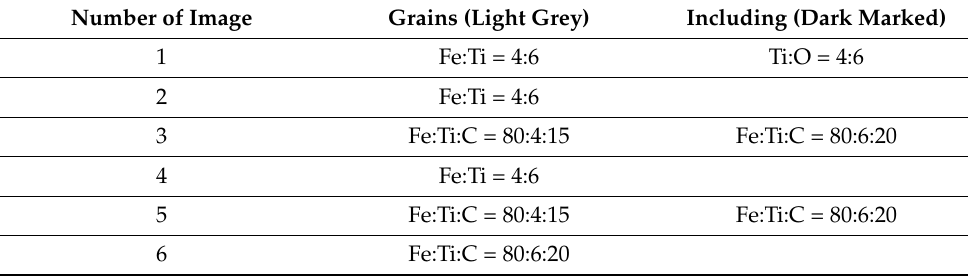
Figure 6. SEM and optical micrographs of the typical structure and microhardness of the DED of a Ti-Fe graded multilayer sample produced by the 3rd mode. Table 3. Structural components of graded structures from Figure 6. Number of